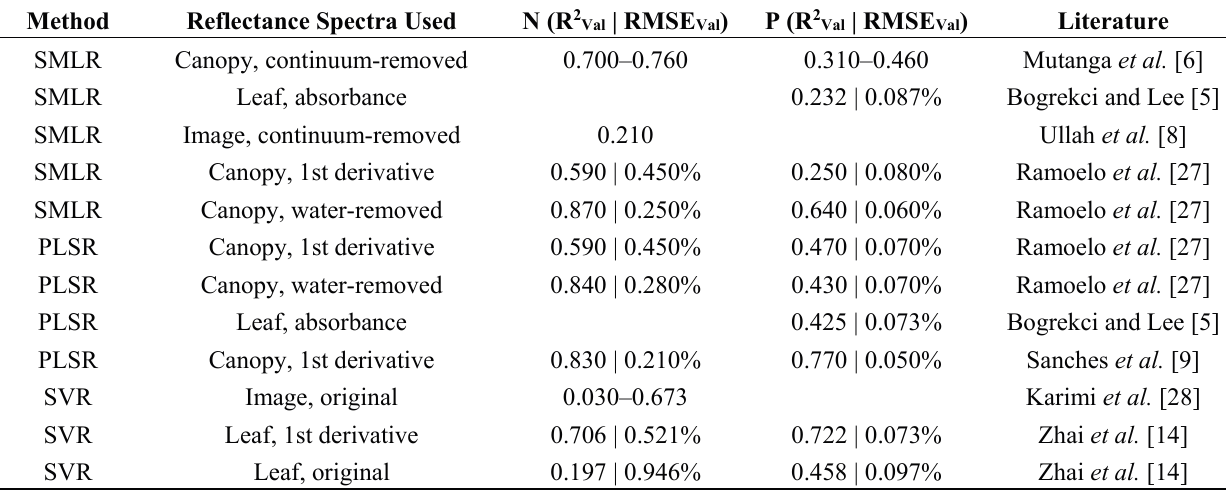
Table 2. A list of some literature on N and P estimations using multivariate regression methods. SMLR, stepwise multiple linear regression; PLSR, partial least squares regression; SVR, support vector